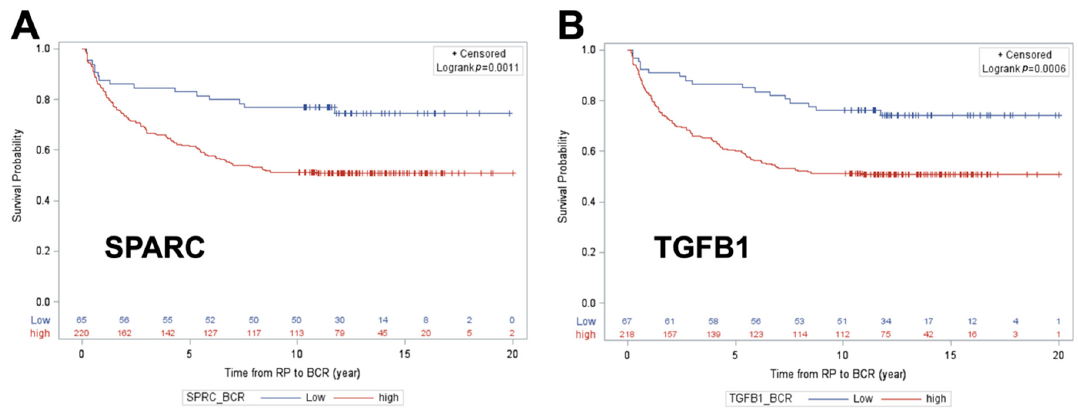
Figure 3. Kaplan–Meier BCR-free survival curves across high versus low groups for SPARC ( A ) and TGFB1 ( B ).